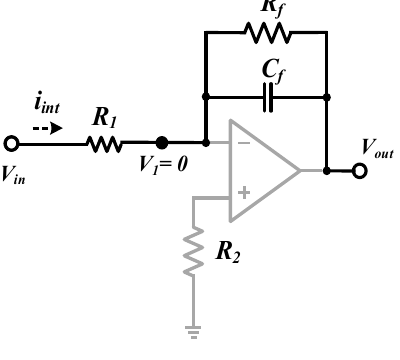
Figure 9. Optimized integral circuit.